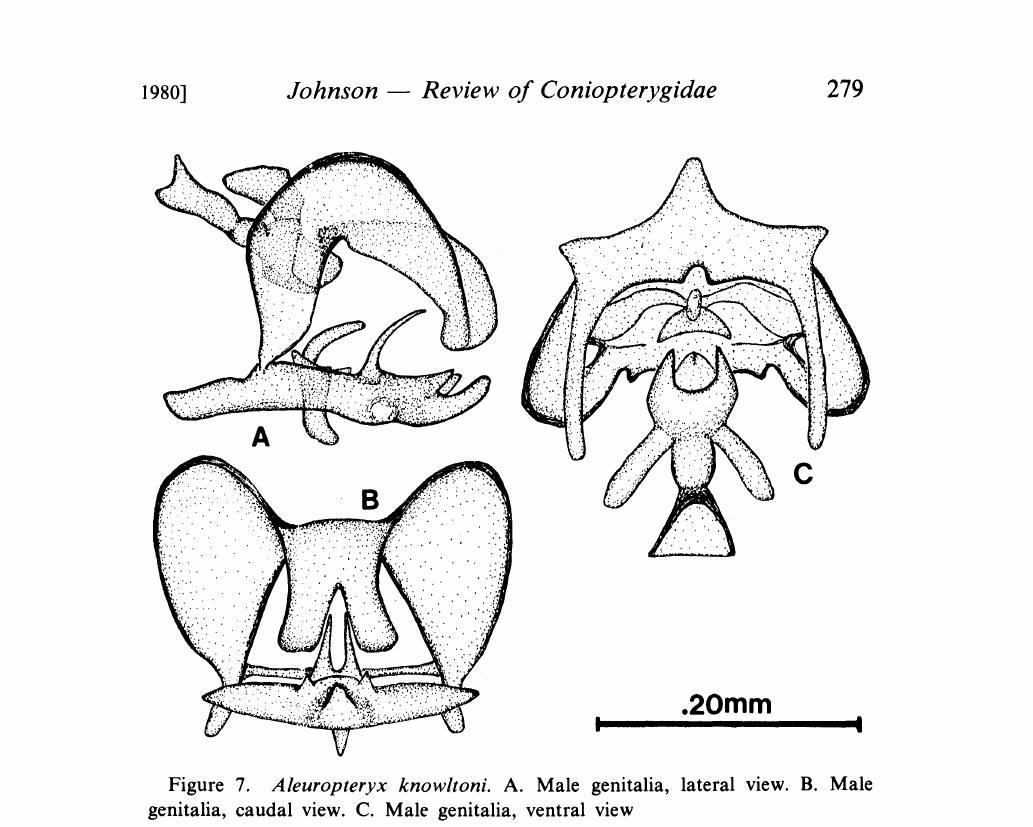
Figure 7. Aleuropteryx knowltoni. A. Male genitalia, lateral view. B. Male genitalia, caudal view. C. Male genitalia, ventral view caudo-lateral to transverse plate bearing 4 setae. Transverse plate formed of 2 curved dorsally directed processes joined ventrally to form a large laterally flattened ventral process and a pair of small, acute antero-lateral processes. Apophyses of 9th sternum short,